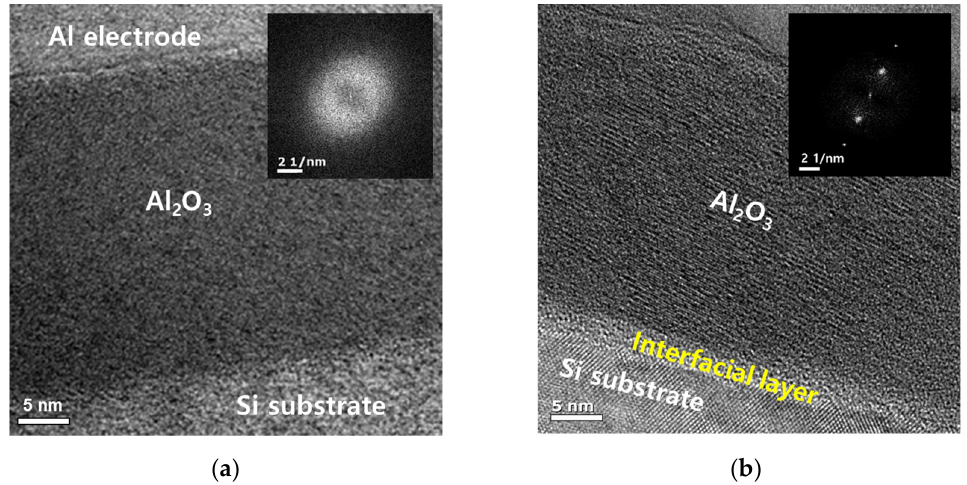
Figure 2. Transmission electron microscope (TEM) image and selective area diffraction pattern (SADP) of ( a ) as-deposited Al/Al 2 O 3 /Si gate stack and ( b ) Al/Al 2 O 3 /Si gate stack after PMA at 400 °C under a N 2 gas flow in a furnace for 30 min. PMA was performed at 400 °C for 30 min after Al 2 O 3 film deposition. After PMA on the Al 2 O 3 film, oxygen in the dielectric film diffused toward the Si substrate. Accordingly, Si and oxygen form a bond in the SiO X (x = 1–2) state, thereby forming an IL with a thickness of 2.5 nm [8,17] (Figure 2b). As IL was formed between Al 2 O 3 and Si, the thickness of Al 2 O 3 decreased from 28.7 to 26.9 nm after PMA. Furthermore, as shown in SADP, amorphous Al 2 O 3 is converted to polycrystalline Al 2 O 3 via PMA [18]. The normalized capacitance vs. voltage curves before and after PMA of S1 and S2 are shown in Figure 3. The graphical ((C OX /C MOS ) 2 − 1)(V G ) method [19] was applied to the normalized capacitance vs. voltage curve to extract V fb . The V fb of as-deposited S1 was 1.65 V, showing a considerable flat-band voltage shift ( ∆ V fb ≈ 2.54 V) compared with the theoretical value of Al 2 O 3 dielectric (V fb ≈ − 0.89 V). This V fb shift resulted from defects, such as carbon impurities that occur during Al 2 O 3 deposition via PEALD. However, in the case of S2 samples with an increased O 2 plasma exposure time, the V fb of S2_as_dep is 0.61 V, exhibiting a smaller ∆ V fb compared with that of S1. This is because the amount of negatively charged defects inside S2 is smaller than that of S1.